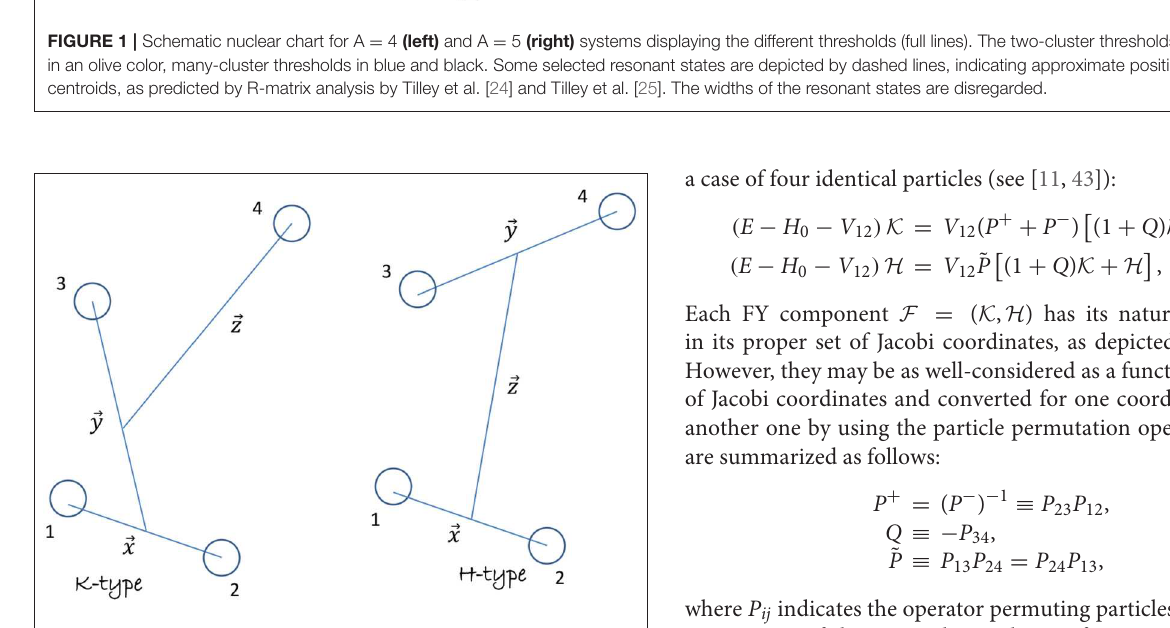
FIGURE 2 | Four-particle partitions K 4 12,3 and H 34 12 , together with the associated Jacobi coordinate